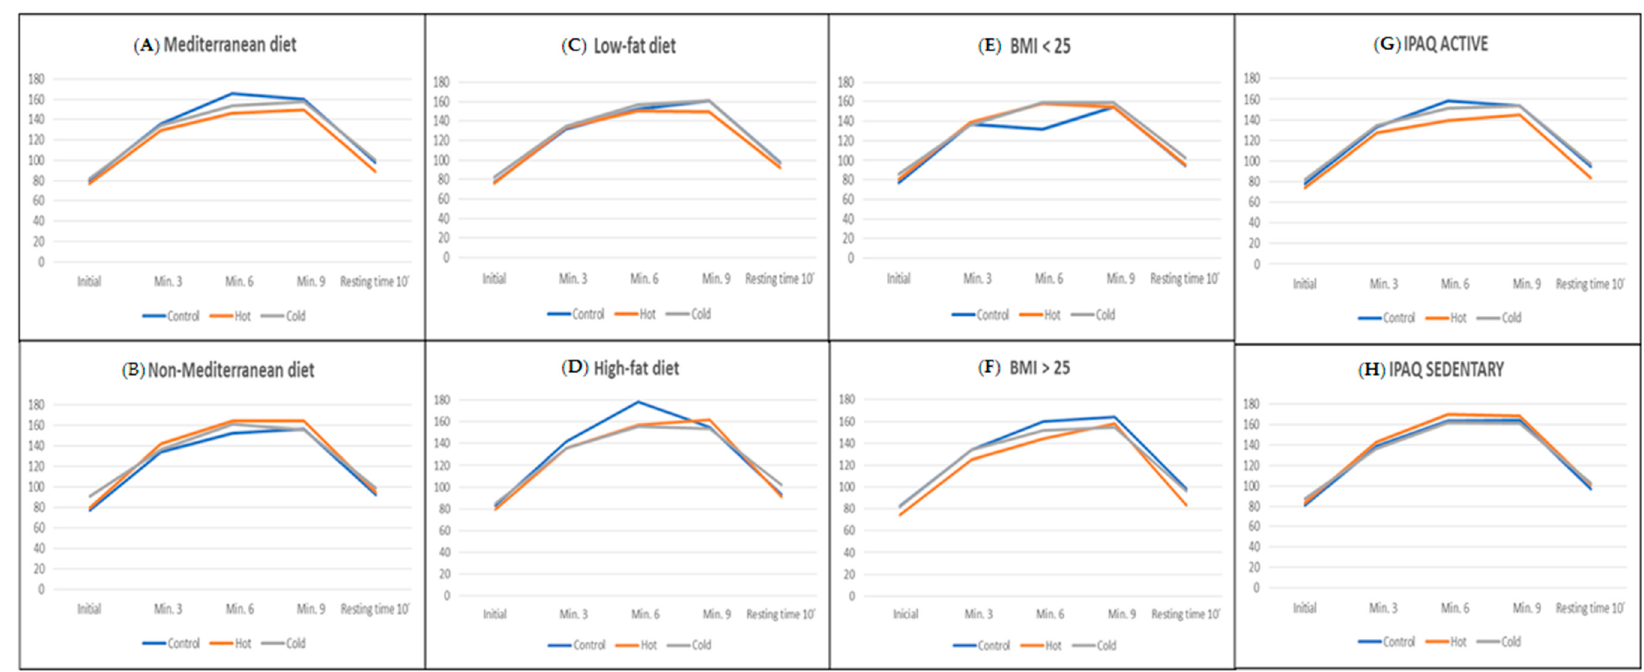
Figure 3. Heart rate during the test and after 10 min of resting time, considering the environmental conditions and according to the dietary habits and lifestyle of the participants, as follows: ( A ) Mediterranean diet, ( B ) non-Mediterranean diet, ( C ) low-fat diet, ( D ) high-fat diet, ( E ) BMI < 25, ( F ) BMI > 25, ( G ) IPAQ active, ( H ) IPAQ sedentary.